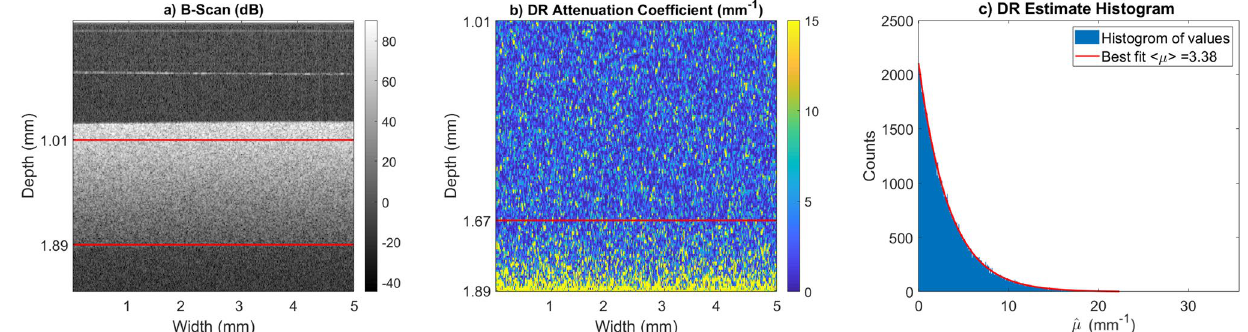
Figure 2. This figure demonstrates the validity of the likelihood function given in Eq. (17) by considering the distribution of attenuation coefficients for a very homogeneous phantom. Both the analysis and figure creation were done in Matlab 2019a 27 , https ://www.mathw orks.com/. ( a ) An OCT B-scan of a phantom made by suspending silica beads with mean diameter of 0.47 micron and a refractive index of 1.425 in water which has a phase refractive index of 1.32 28 . The red lines indicate a homogeneous region where the DR estimate is made. ( b ) The DR estimate for the attenuation coefficient of the B-Scan shown in ( a ). The overestimation artifact is clear towards the bottom part of the scan. ( c ) Histogram of estimated values for the top 100 rows of pixels of the DR estimate on the B-scan. Because the phantom is very homogeneous we expect the histogram to follow Eq. (17) for this region. The exponential fit is in good agreement with the theoretical predicted value of 3.2 mm −